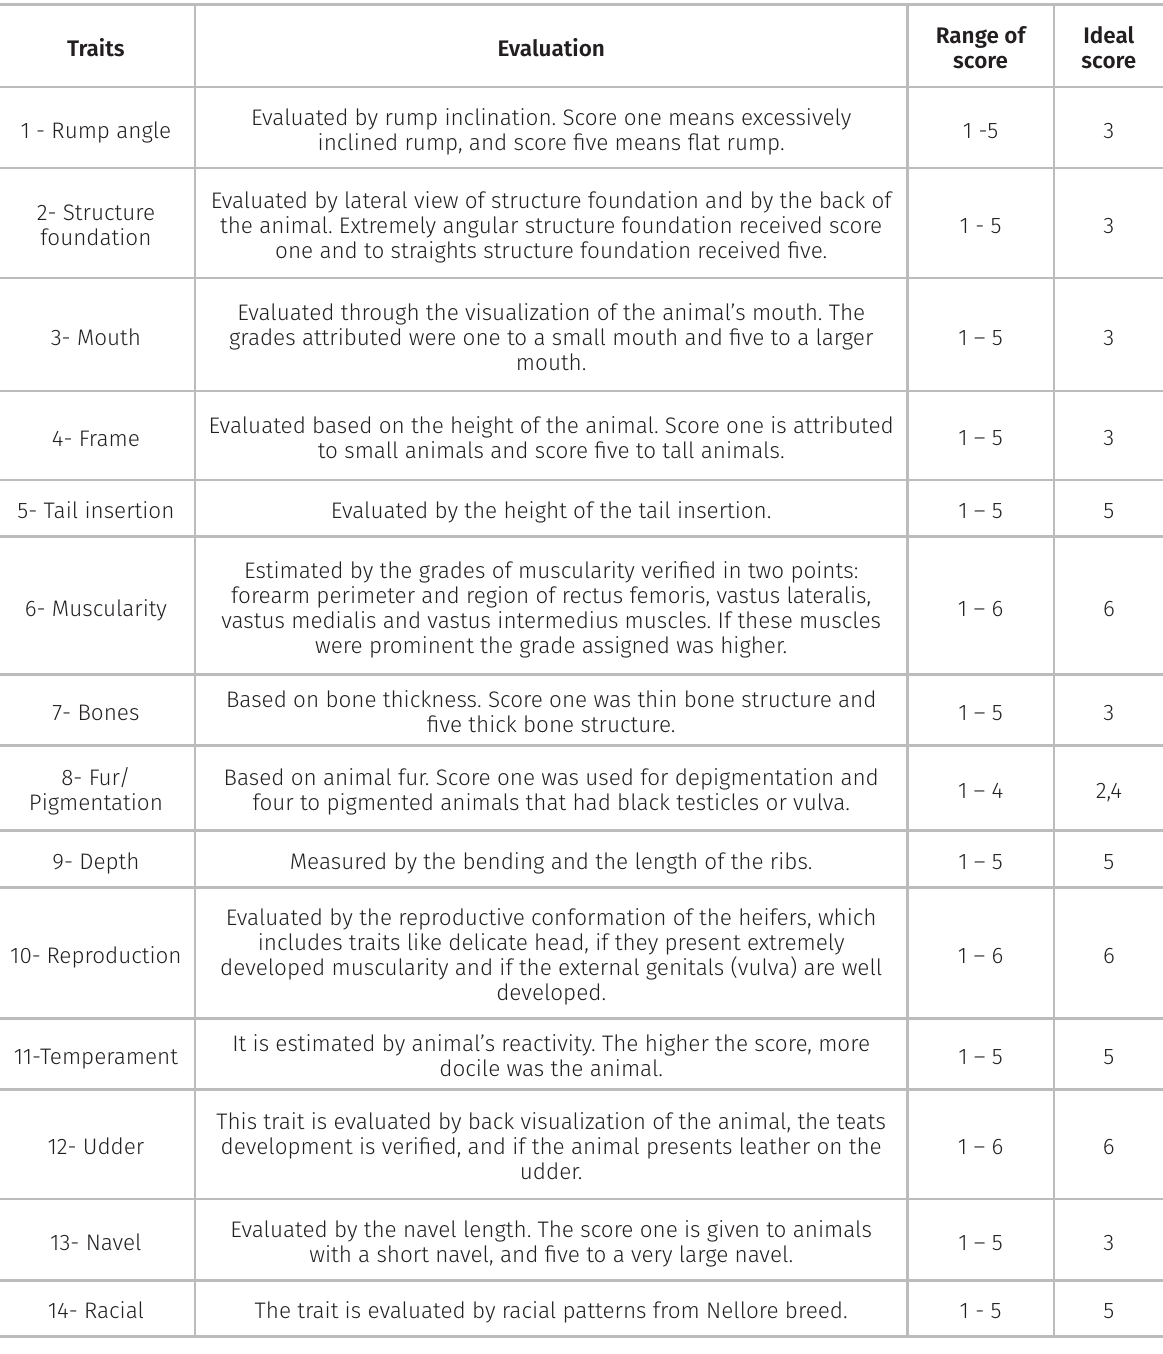
Table I. Visual score traits evaluated in Nellore females, using the method of evaluation of the program Nellore Qualitas. Traits